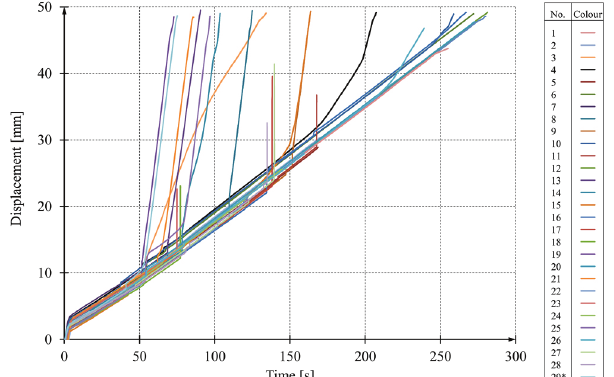
Fig. 17b. Pile head displacements change